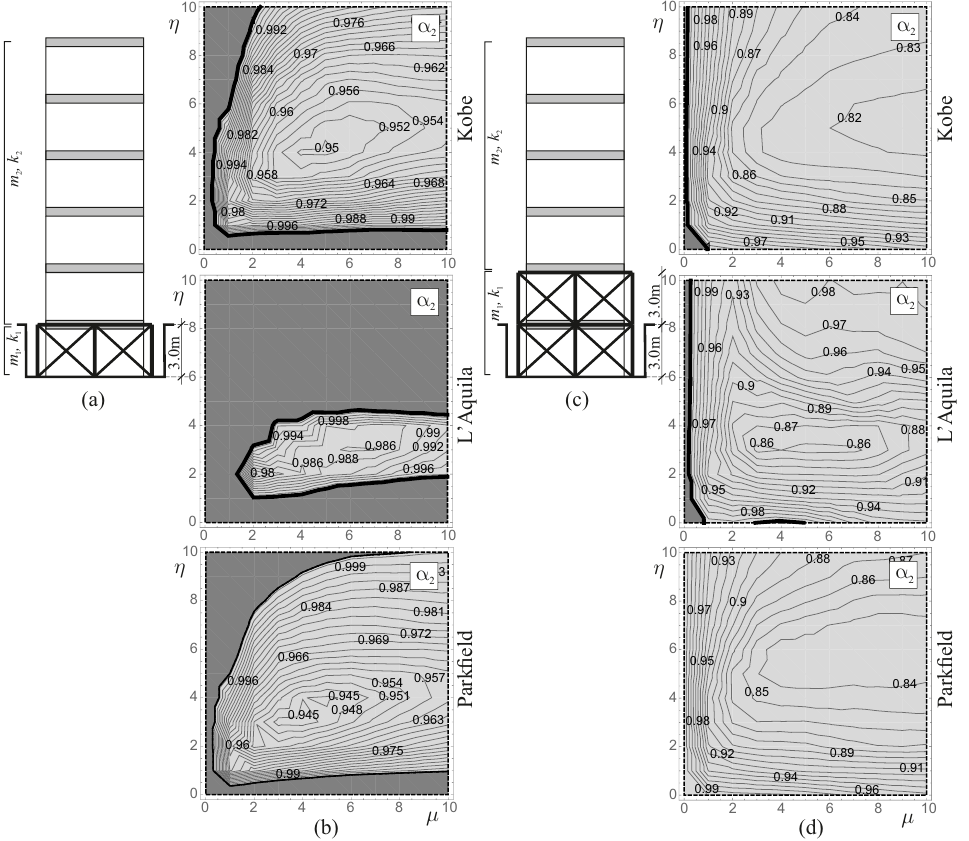
Figure 12. Gain maps: ( a , c ) Geometrical coupling schemes; ( b , d ) Gain maps α 2 for different earth- quakes ( ψ = 0.1, γ =